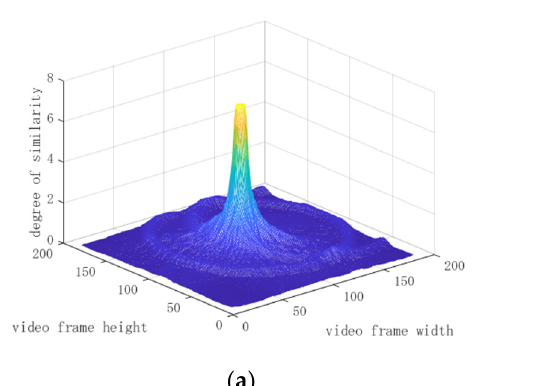
Figure 12. The difference in peak sharpness for the evaluation function h ( x 0 , y 0 , r , q ; t ) : ( a ) Conventional Hough transform; and ( b ) Mexican hat-type ellipse pattern.